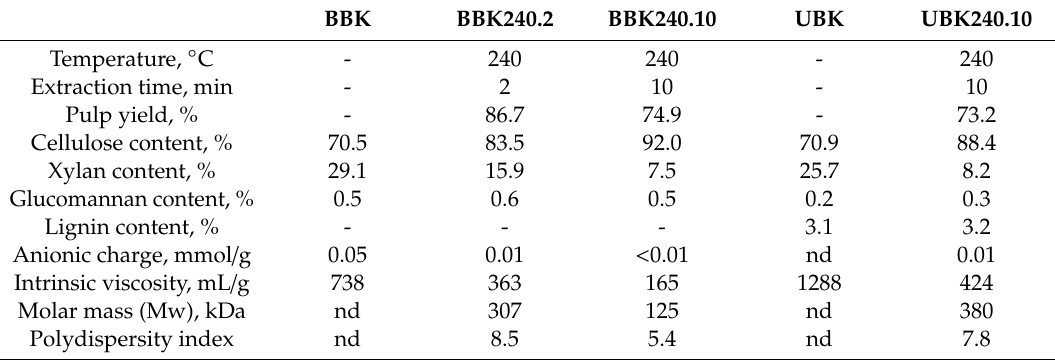
Table 1. Properties of bleached (BBK) and unbleached kraft (UBK) pulp before and after hot water extractions in a flow-through system (flow rate 400 mL / min). BBK BBK240.2 UBK UBK240.10 - 240 240